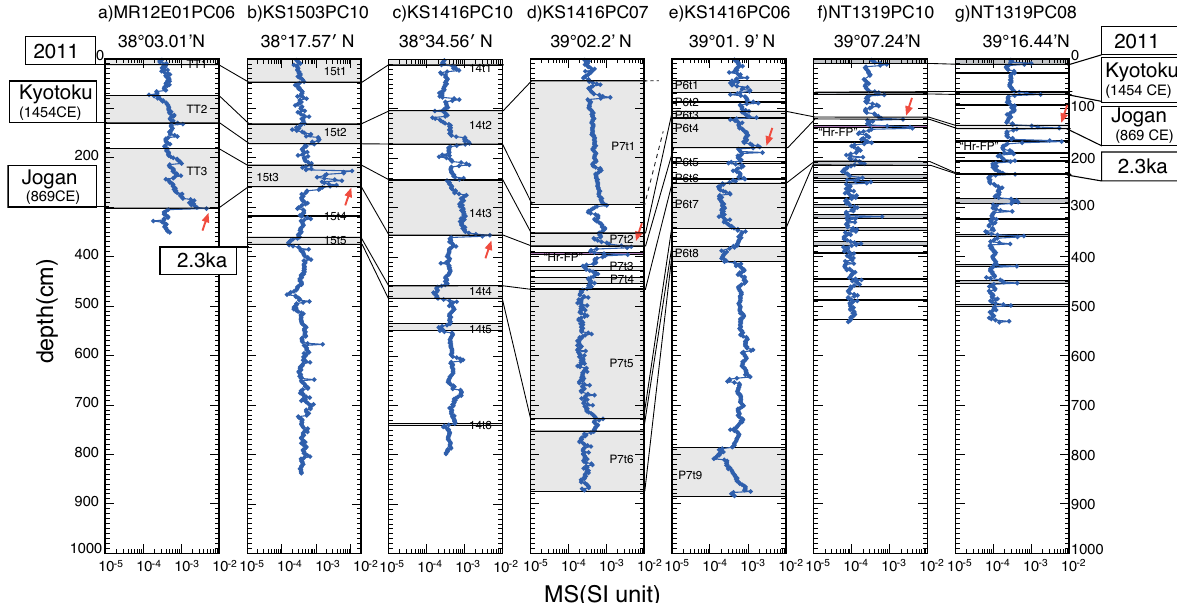
Fig. 8 Contemporaneous turbidite beds and magnetic susceptibility profiles in the Japan trench basins and the slope basins: cores KS1416PC10 and KS153PC10 (Kanamatsu et al. 2023); cores NT1319PC10 and NT1319PC8 (redrawn from Kanamatsu et al. 2017). Red arrows indicate high magnetic susceptibility peaks. Black line shows turbidites correlation in the studied cores. Note scales of horizontal axes (MS) are expressed by log